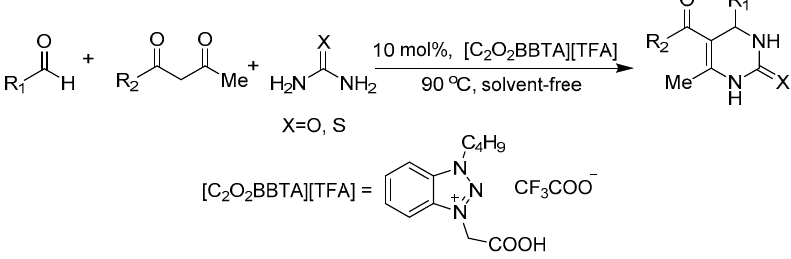
Table 1. Effect of catalyst [C 2 O 2 BBTA][TFA] under different conditions for the reaction of aryl aldehyde, β -ketoester and urea a